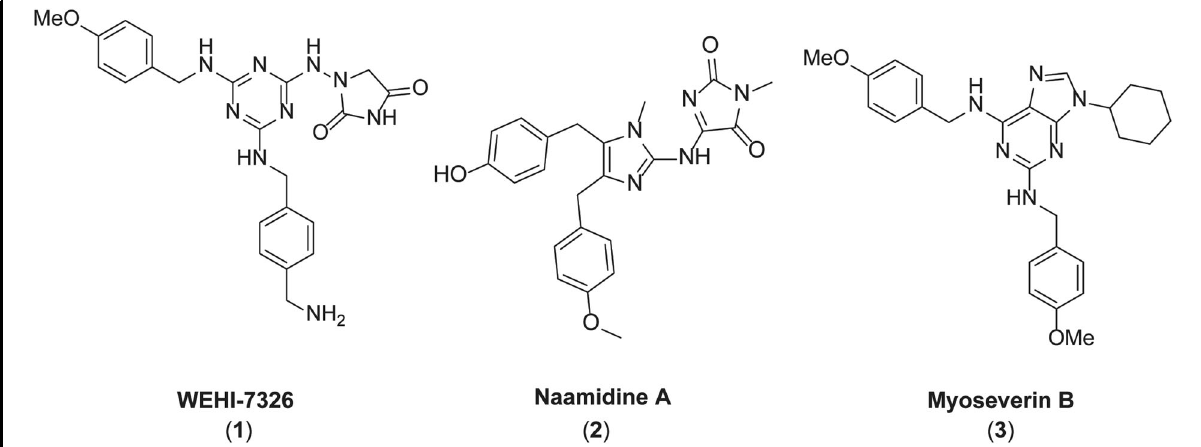
Fig. 1 Discovery of WEHI-7326. Chemical structures of the anti-tumor compound WEHI-7326, natural product Naamidine A, and purine library compound Myoseverin